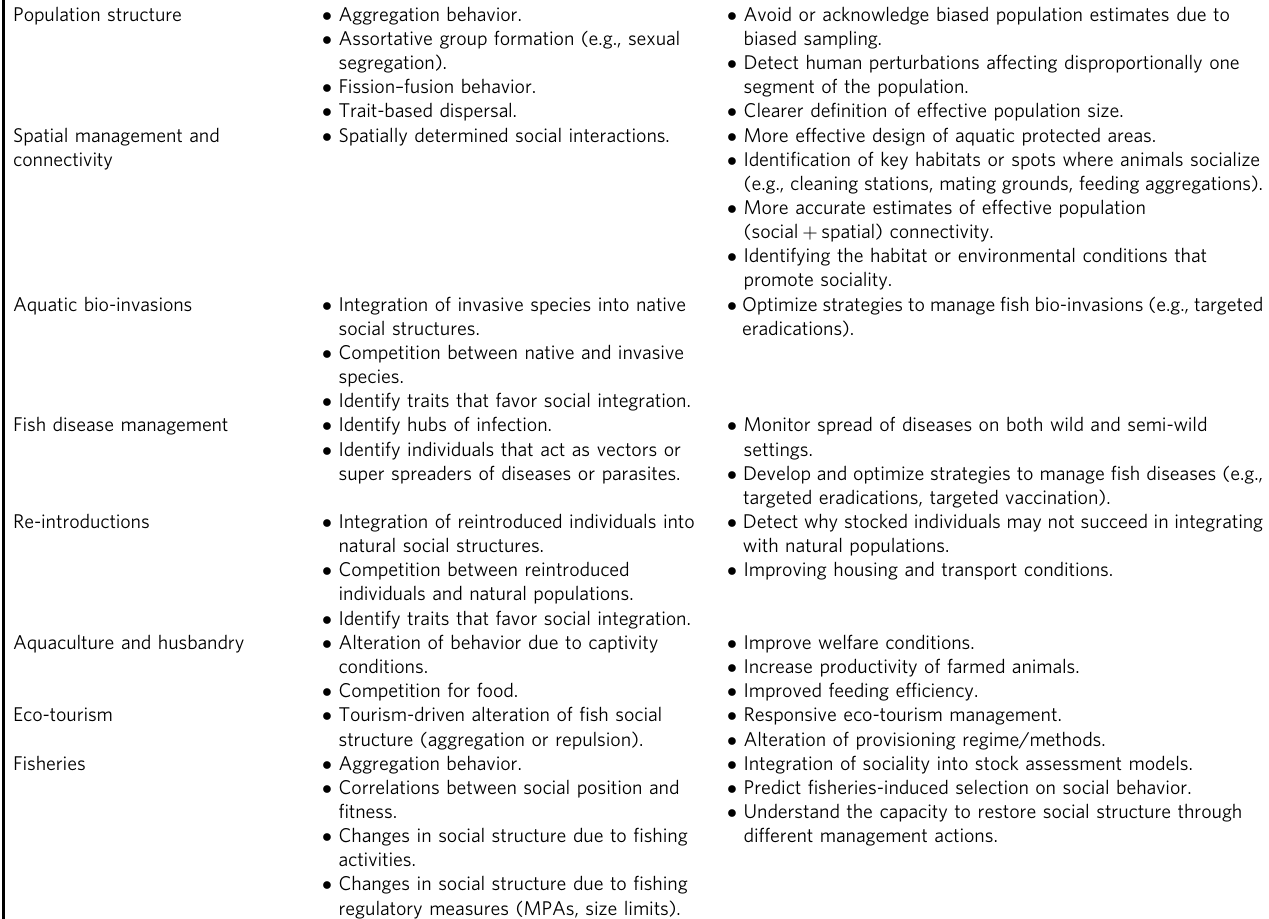
Table 1 Bene fi ts of social network analysis for fi sh conservation. Conservation theme Social mechanisms that can be addressed with social networks Population